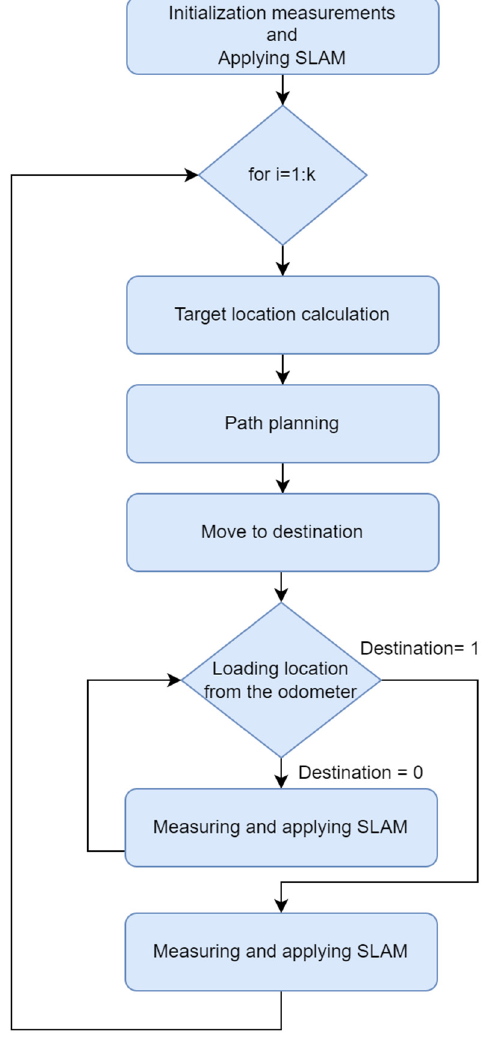
Figure 6. Active SLAM algorithm flowchart.